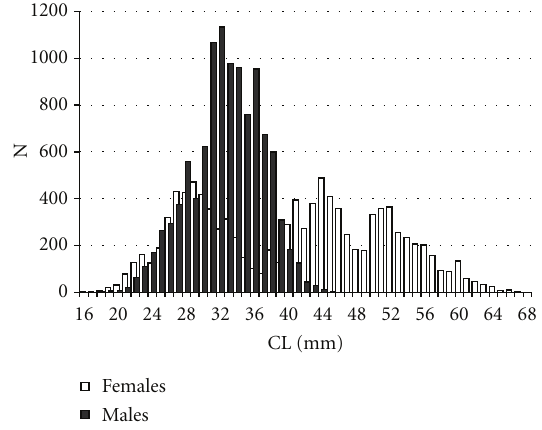
Figure 2: Length frequency distributions (LFDs) of females and males of Aristaeomorpha foliacea caught in the southern Tyrrhenian